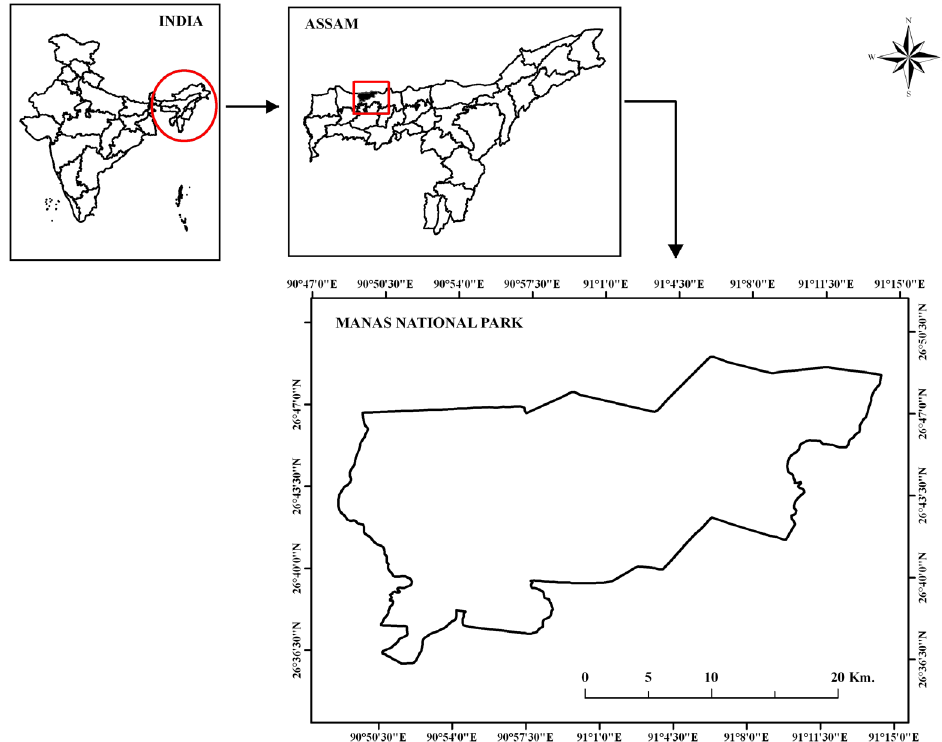
Figure 1. Manas National